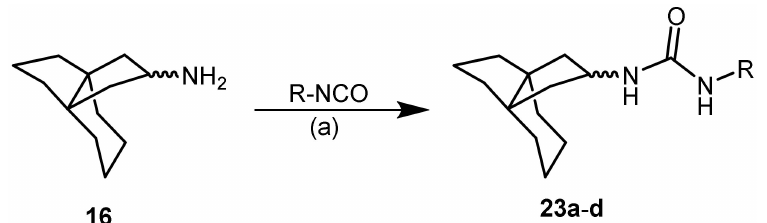
Scheme 4. Synthesis of propellane-based urea derivatives 23. Reagents and reaction conditions: